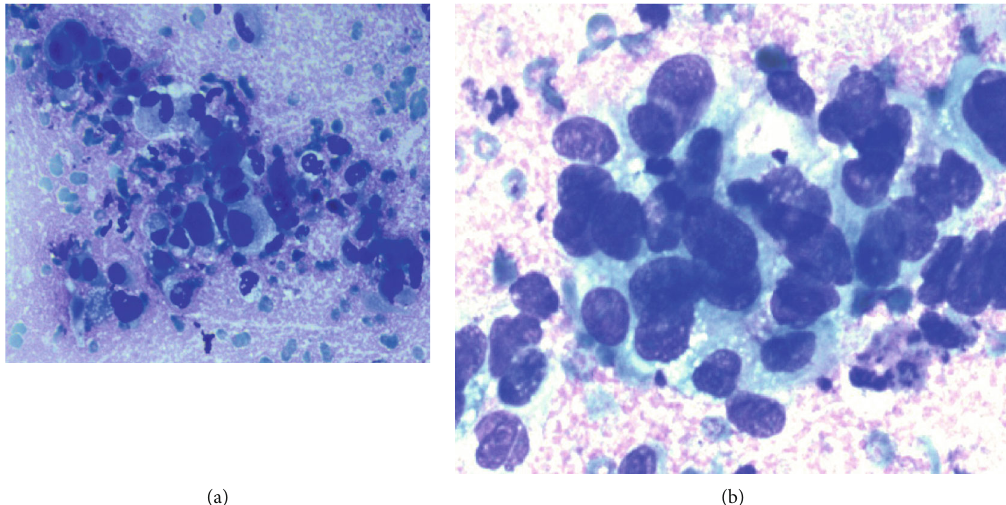
Figure 1: (a) Cytology shows hypercellular material containing atypical cells, irregular borders, and hyperchromasia, 10x. (b) Close view, 40x of the atypical cells with hyperchromasia and overlapping and clear